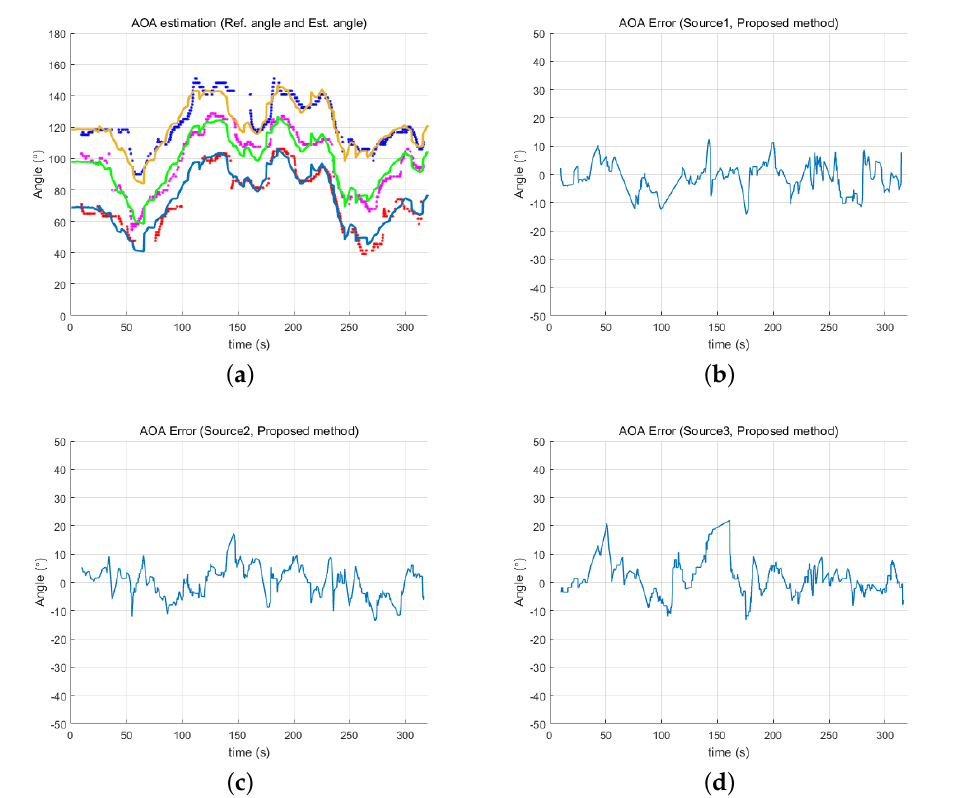
Figure 10. Error of angles determined by the proposed method: ( a ) reference angles and estimated angles of three acoustic sources from the proposed method; ( b ) error of Source 1; ( c ) error of Source 2; and ( d ) error of Source